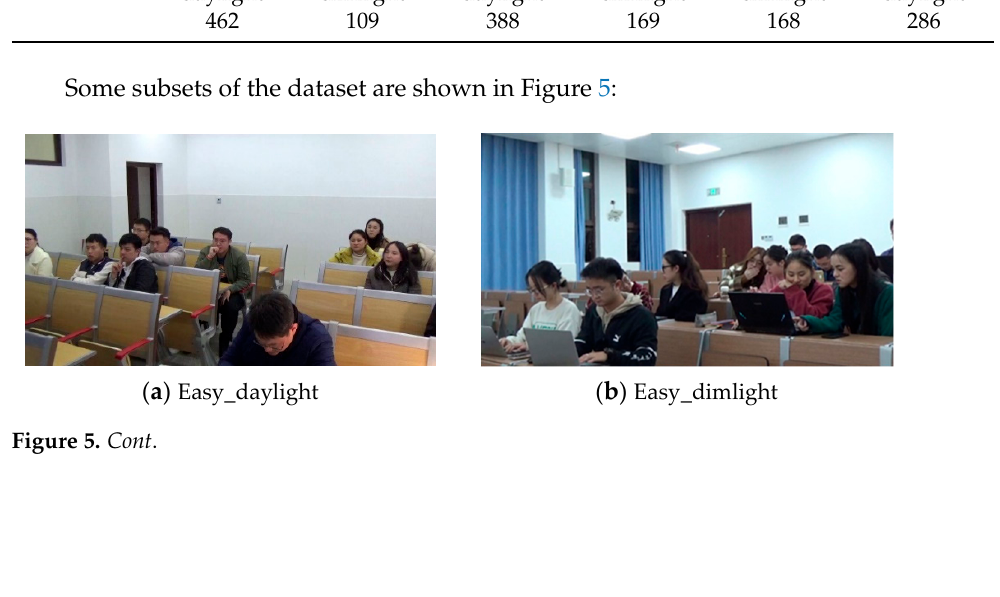
( f ) Hard_dimlight Figure 5. Partial image in Classroom-Face. According to the number of people, the data set is di- vided into Easy, Medium, and Hard. According to the light, the data set is divided into dimlight and daylight. 4.2. Train Details During training, we used the bounding box regression loss combined with the face loss as our fi nal loss. The loss function is as follows: 𝐿𝑜𝑠𝑠 (cid:3029)(cid:3042)(cid:3051) = 𝐿 (cid:3008)(cid:3010)(cid:3042)(cid:3022) = 1 (cid:3398) |(cid:3003)∩(cid:3003) (cid:3282)(cid:3295) | |(cid:3003)∪(cid:3003) (cid:3282)(cid:3295) | + |(cid:3004)(cid:2879)(cid:3003)∪(cid:3003) (cid:3282)(cid:3295) | |(cid:3004)| (13) In Equation (13), we choose the GIoU loss function as the bounding box regression loss function, where C represents the smallest rectangle containing B and 𝐵 (cid:3034)(cid:3047) . B is the prediction box. 𝐵 (cid:3034)(cid:3047) refers to the ground-truth box. 𝐿𝑜𝑠𝑠 (cid:3033)(cid:3028)(cid:3030)(cid:3032) = (cid:2869) (cid:3015) ∑ (cid:3398)[𝑦 (cid:3041) ∗ 𝑙𝑜𝑔𝑥 (cid:3041) + (1 (cid:3398) 𝑦 (cid:3041) ) ∗ log (1 (cid:3398) 𝑥 (cid:3041) )] (cid:3015) (cid:3041) (14) In Equation (14), the face prediction loss is the BCE loss, 𝑦 (cid:3041) is the true label, and 𝑥 (cid:3041) is whether the model predicts a face or not. Equation (15) represents the overall loss value of the model.